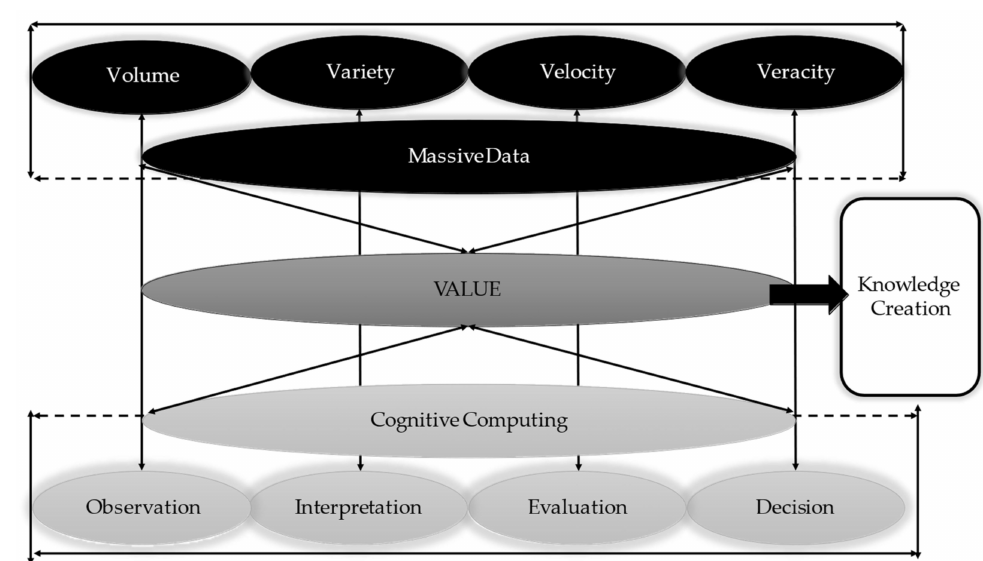
Figure 12. Linking between CC and massive data for knowledge